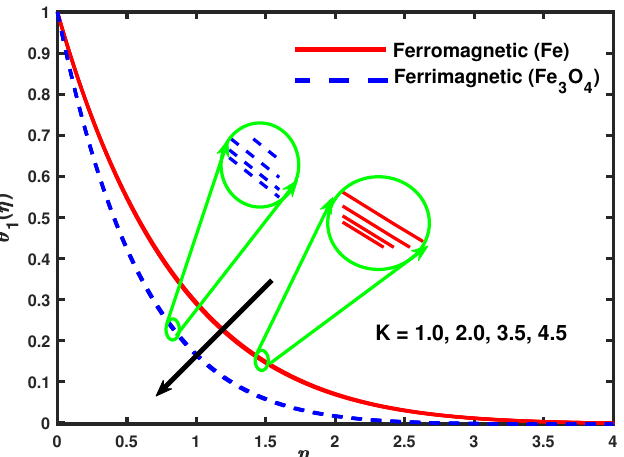
Figure 10. Impact of magnetic nano-particles and micro-rotation parameter ( K ) on the temperature profile θ 1 ( η ) .